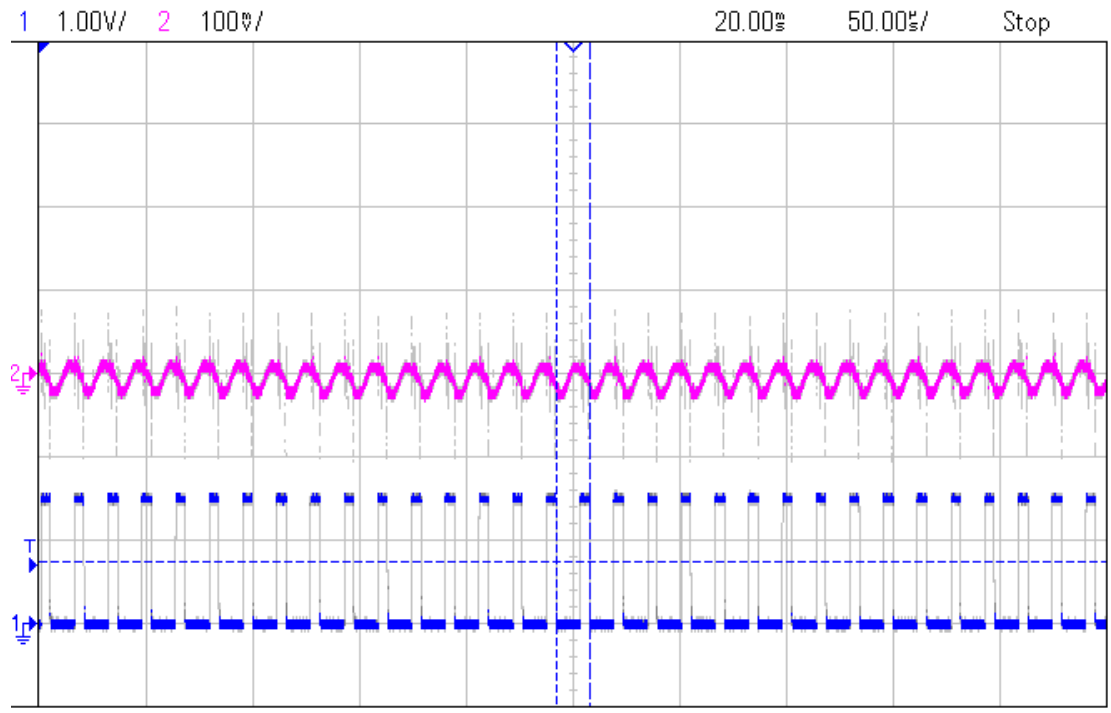
Figure 15. Output voltage ripple (upper plot) and PWM (bottom plot) for PI closed-loop operation, with e 3 = 0 V.